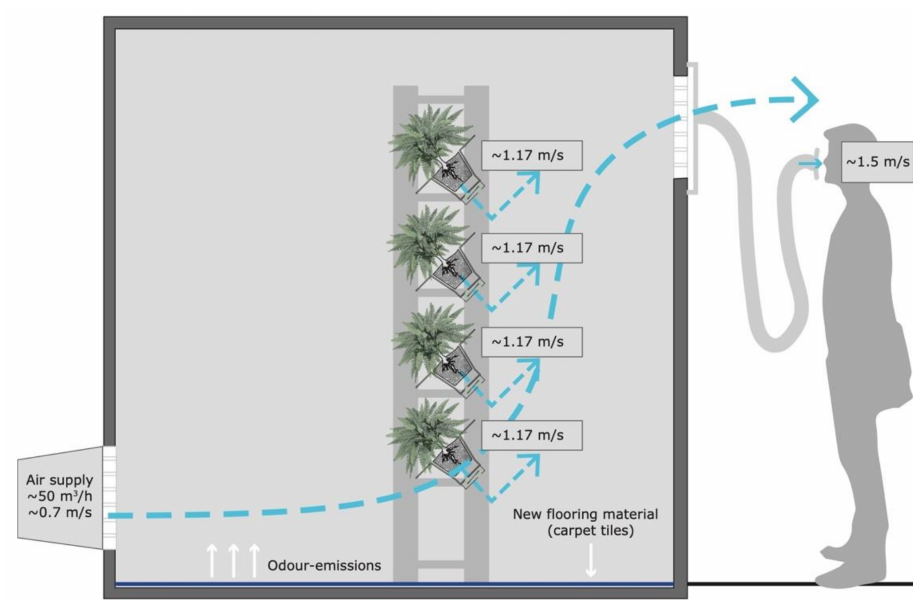
Figure 2. Setup of Chamber A (including an active plant-based system).